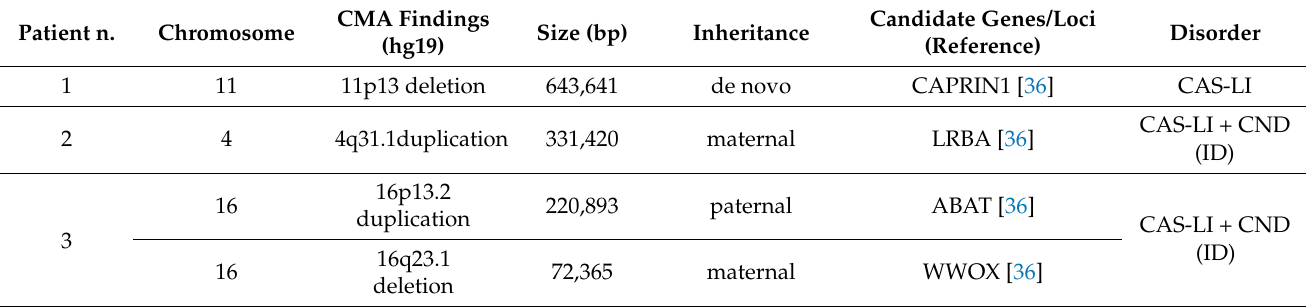
Table 2. List of causative copy number variants (C-CNVs) detected in our